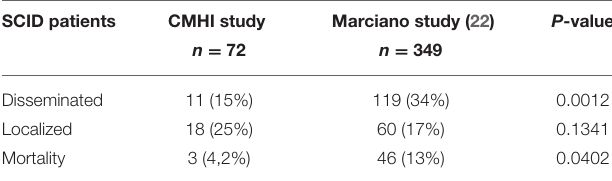
TABLE 2 | Comparison of BCG-associated complications in two study